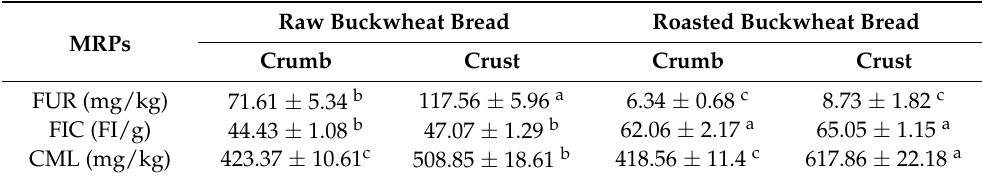
Table 2. Formation of Maillard reaction products (MRPs) in buckwheat bread formulated with raw and roasted buckwheat flour.